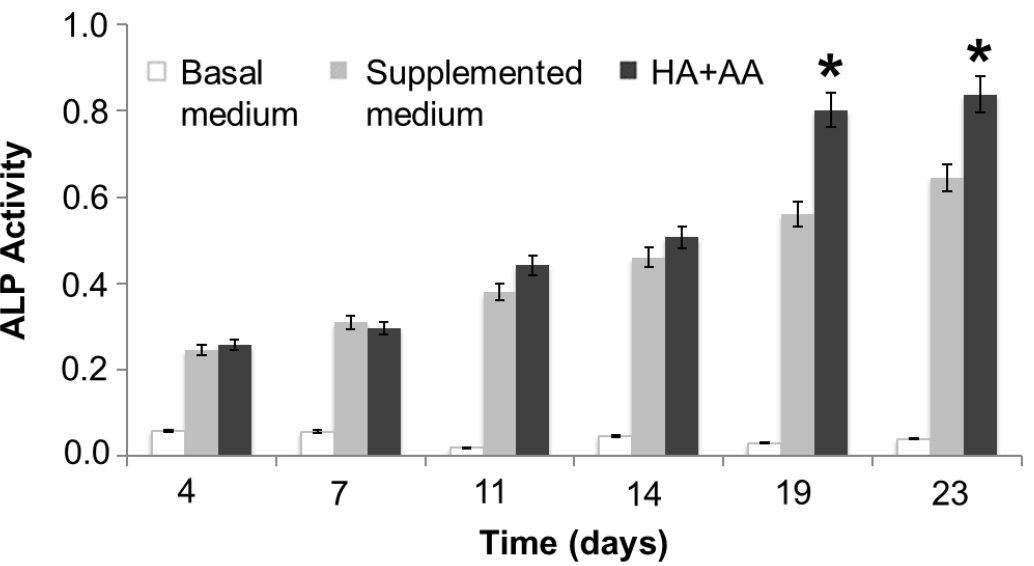
Figure 4. ALP activity assay. The reported data represent the means of three independent experiments. The HA+AA group is significantly different from the supplemented medium group after 19 and 23 days of culture (* p < 0.05).